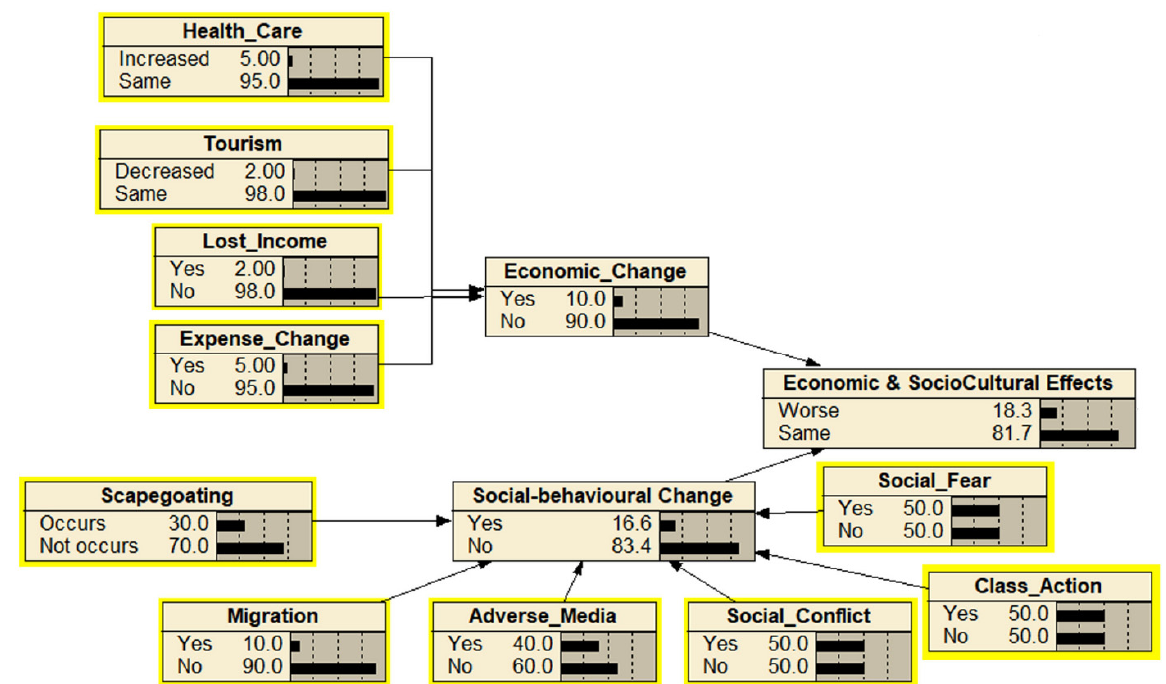
Figure 6. The Bayesian belief network for the endpoint “economic and socio-cultural effects”. Each node (box) represents the probability of hazards that might occur within the next 30 years as results of the release of Wolbachia -infected Ae. aegypti . Parent nodes are in the yellow boxes.